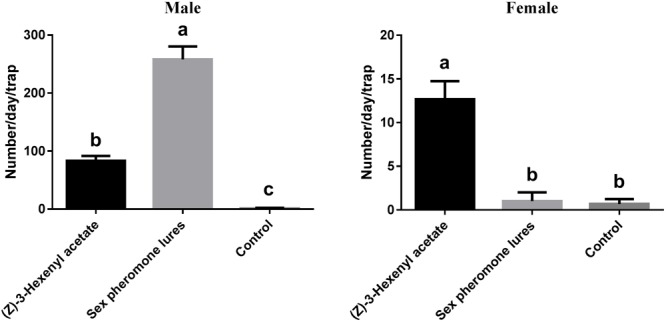
Total numbers of DBC captured in traps with different chemicals. Mean ± SE (N= 3). Significant differences between different treatments were analyzed via ANOVA at a significance level of P < 0.05, and significant differences are indicated with different letters.